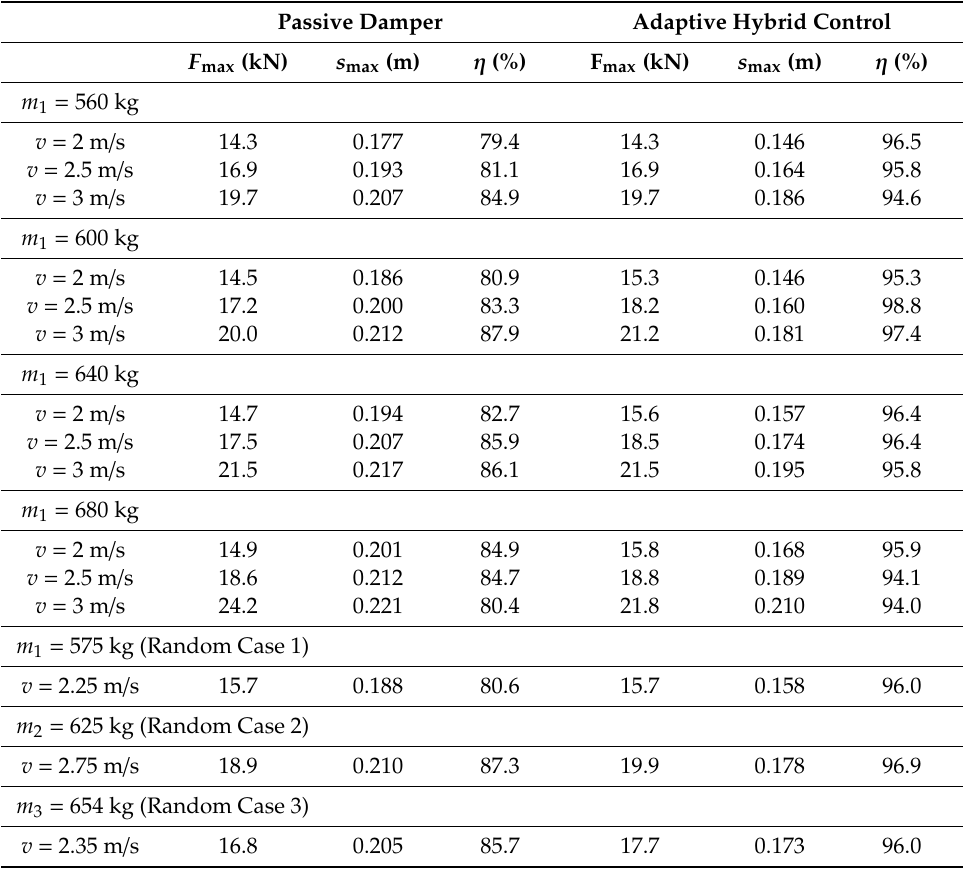
Table 5. Damper performance using the passive damping and adaptive hybrid control in di ff ering landing